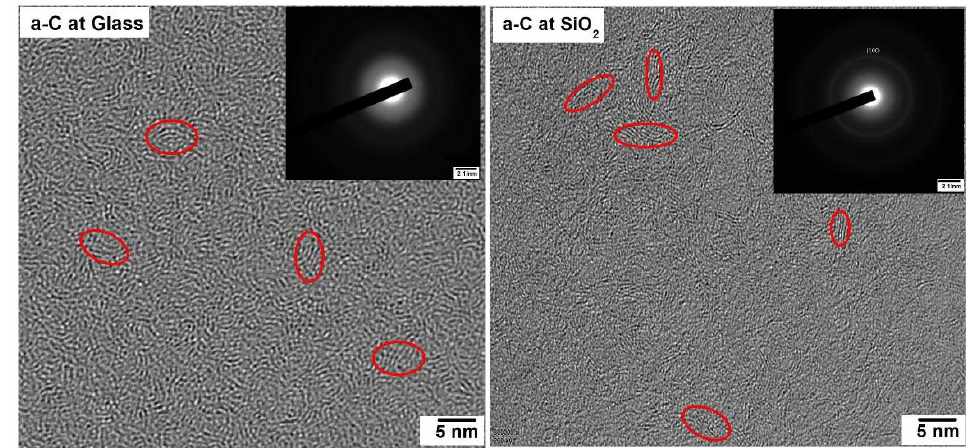
Figure 1. HRTEM of sample thin films; inset: diffraction